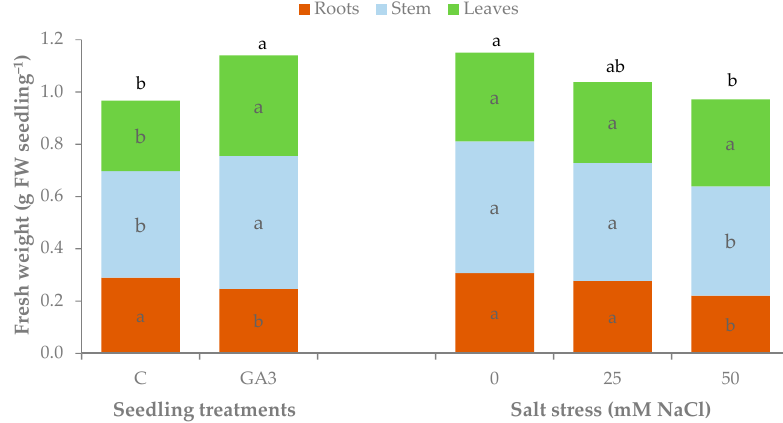
Figure 8. Effect of the seedling treatments (C, untreated control, GA3, gibberellic acid spray 10 − 5 M) and salt stress (0, 25, and 50 mM NaCl in the irrigation water) on the total, root, stem, and leaf fresh weight of sweet pepper seedlings (within each experimental factor. Bars of the same color with different letters are significantly different at p < 0.05 according to the LSD test.